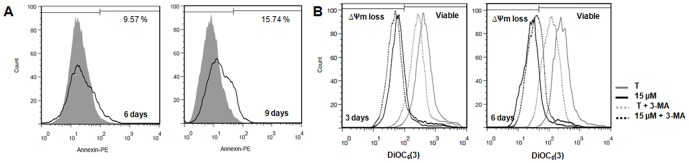
Annexin V-PE labeling and mitochondrial transmembrane potential following exemestane treatment.(A) Annexin V-PE labelling of MCF-7aro cells treated with exemestane (15 µM) for 6 and 9 days of treatment. Cells cultured with T were considered as control and for 6 days present 3.54% and for 9 days 5.58% of Annexin V binding. Data presented in histograms were analysed with FlowJo Software (Tree Star, Inc), correspond to cells gated for negative 7-AAD staining and are representative of one independent assay. The grey filled line corresponds to control and the black line to exemestane at 15 µM. (B) Mitochondrial transmembrane potential (ΔΨm) of MCF-7aro cells treated with exemestane (15 µM) with or without 3-MA (1 mM), for 3 and 6 days. Viable cells and cells with ΔΨm loss were identified. Data presented in histograms were analysed with FlowJo Software (Tree Star, Inc) and are representative of one independent assay.